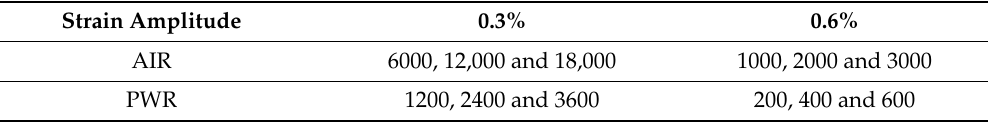
Figure 3. Location of INCEFA-PLUS holds within the hysteresis loop. Table 3. Cycle number after which a hold takes